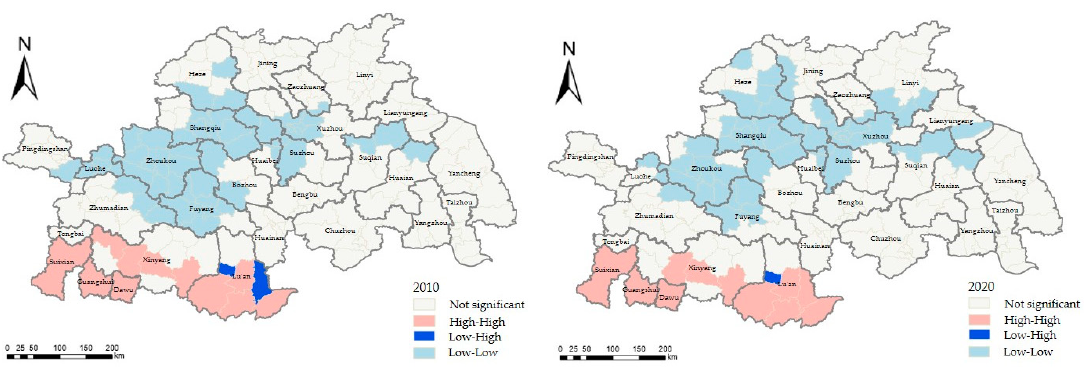
Figure 7. Local autocorrelations in SDI.